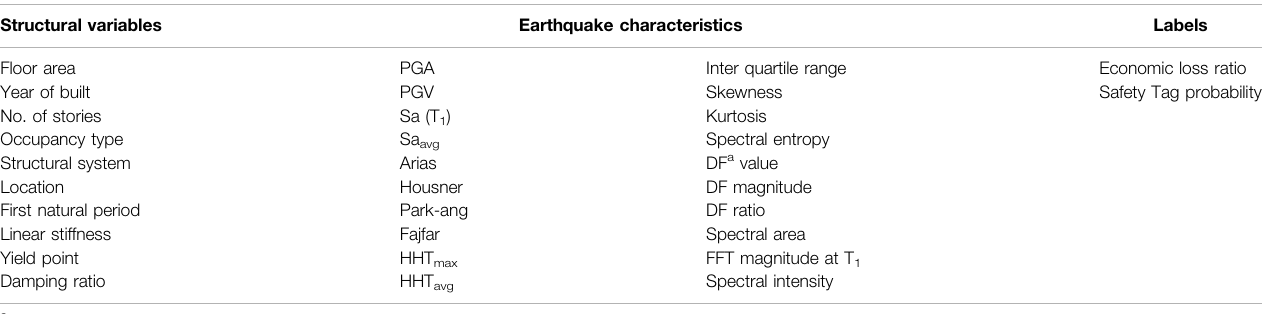
TABLE 2 | List of features and labels for the regional damage assessment dataset.